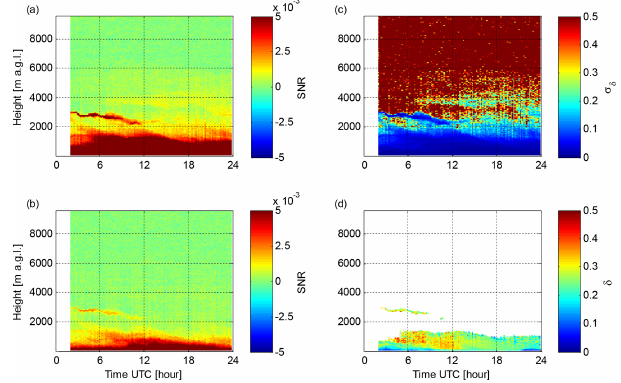
Figure 5. Averaged profiles at Limassol on 21 April 2017 at 20:00– 21:30UTC. All profiles have been smoothed by a 300m running mean. (a) Backscatter by PollyXT (wavelengths 355–1064nm) and attenuated backscatter by Halo (1565nm). (b) Particle linear de- polarization ratio. Error bars represent measurement uncertainty. (c) Lidar ratio. For PollyXT β 355 , β 532 , LR 355 and LR 532 , a near- range telescope is used for data < 900ma.g.l.